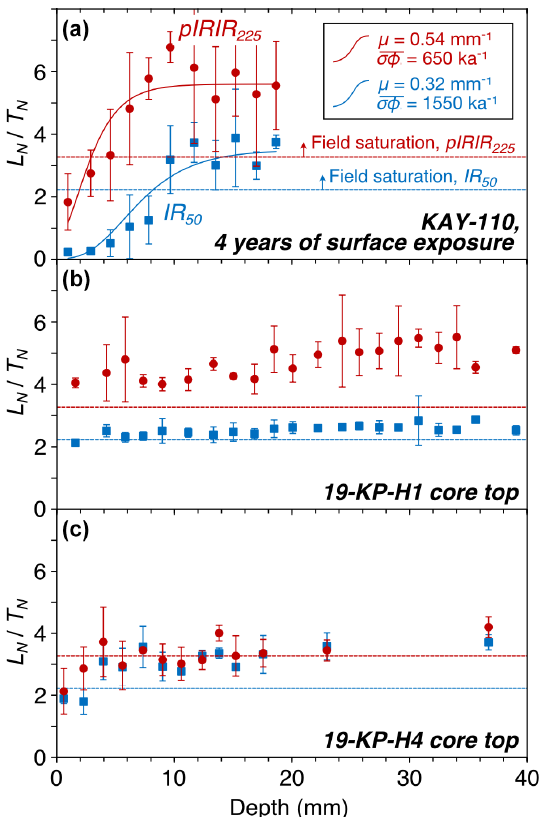
Figure 6. Sensitivity-corrected luminescence intensity for the IR 50 and pIRIR 225 signals, with the IR 50 signal being more bleachable when exposed to sunlight. The depth profiles for both signals in both core tops (b, c) are indistinguishable from field saturation, the 95% confidence level for which is indicated with horizontal dashed lines. By comparison, KAY-110 (a) , which was exposed to sunlight for 4 years prior to measurement, shows reduced intensity near the surface due to signal bleaching. For KAY-110, solid lines show a bleaching model fitted to the data to yield estimates of the detrap- ping rate at the rock surface, σφ (ka − 1 ), and the sunlight attenuation coefficient, µ (mm − 1 ) (Methods 1 and Table S2 in the